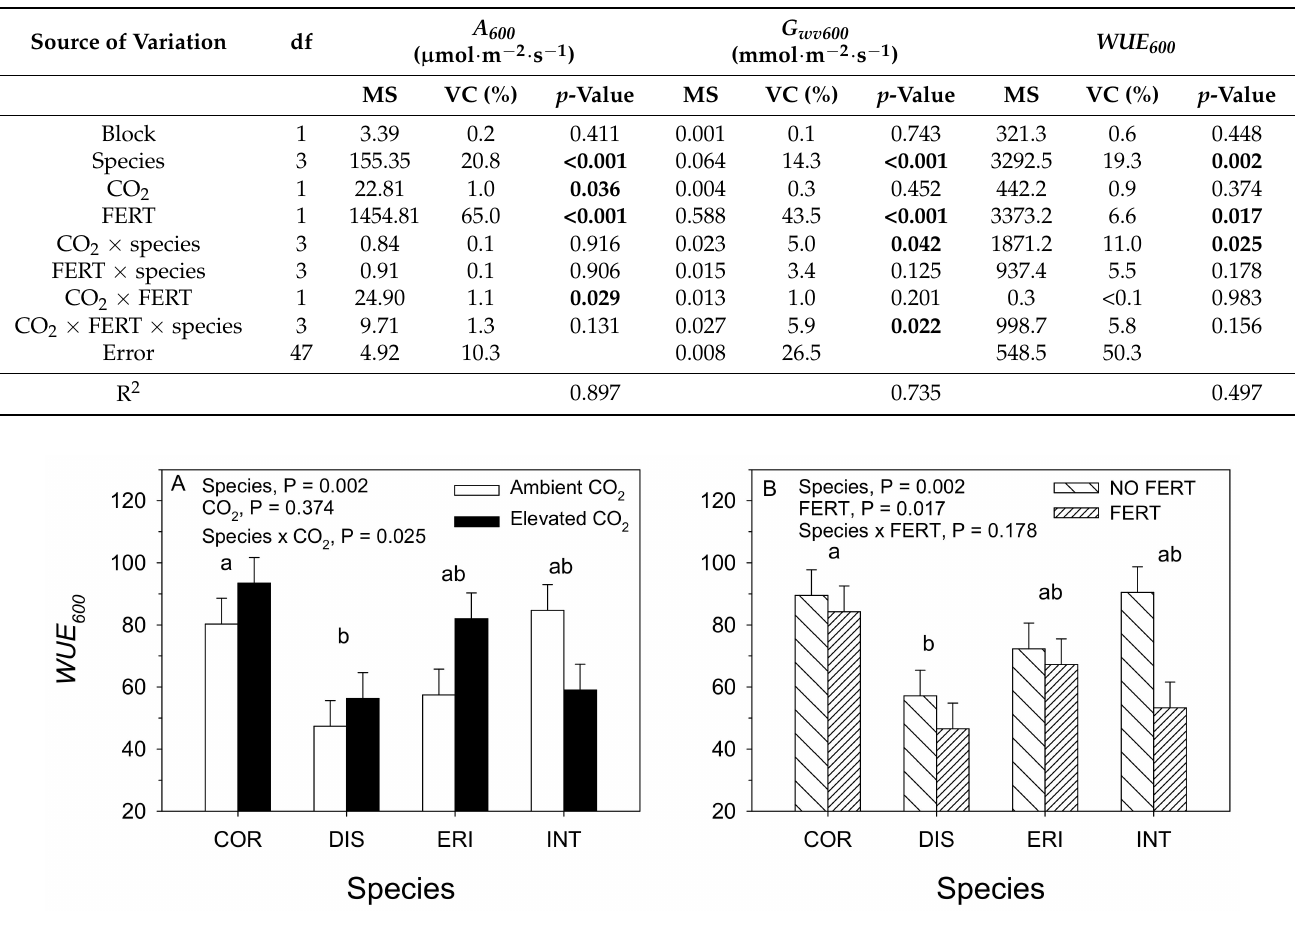
Figure 4. ( A ) Water use efficiency at 600 ppm (WUE 600 ) (mean ± SE) by willow species and CO 2 treatments, 2018, ( B ) by willow species and fertilization treatments, 2018. If lower case letters differ among willow species than significantly different using Tukey’s mean separation test ( p =